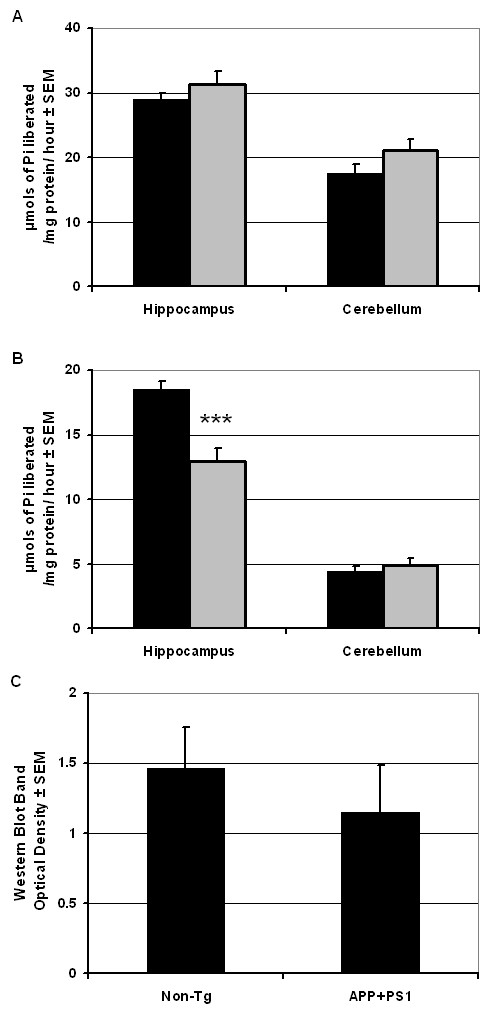
Reduced activity and protein levels of the Na+/K+ ATPase enzyme in APP+PS1 mice. Activity of total (A) and ouabain-sensitive (B) ATPase was assayed colorimetrically in APP+PS1 mice tissue (n = 8, open bars) and non-transgenic littermate tissue (n = 8, solid bars), presented here as μmols of phosphate liberated by ATPase per mg of protein per hour. In the amyloid-containing hippocampus, there was a significant decrease in the specific activity of ouabain-sensitive ATPase in APP+PS1 mice compared to non-transgenic mice, but there was no decrease in cerebellar Na+/K+ ATPase activity. Cerebellar activity was 20% of that seen in non-transgenic hippocampus. Panel C shows the quantitation of the optical density of bands corresponding to the molecular weight of Na+/K+ ATPase using standard Western blot technique. This reveals a trend for decreased protein levels. *** indicates significant differences between APP+PS1 mice and non-transgenic littermates (p < 0.001) when measured by one-way ANOVA.